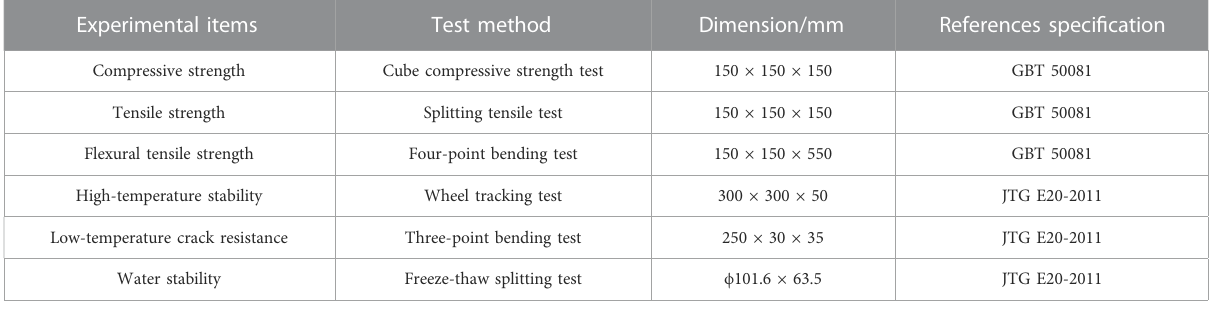
TABLE 2 Specimen dimensions in different test items.